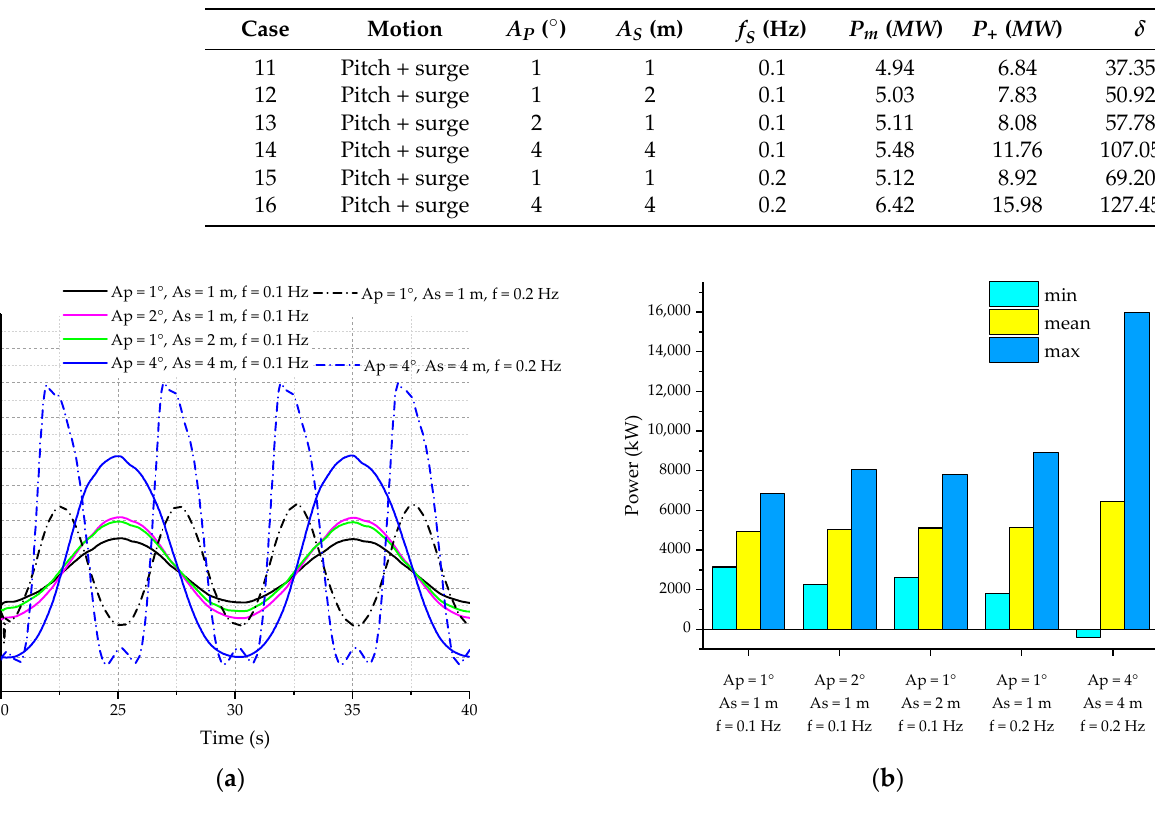
Figure 14. Power performance under same-phase combined motion. ( a ) Power variation versus time; ( b ) the average and extreme